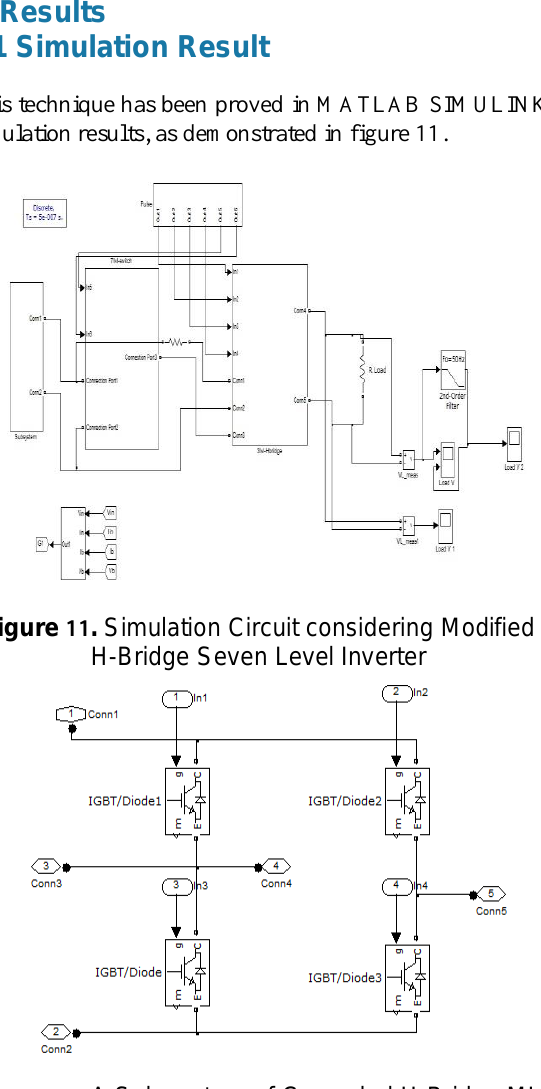
Figure 12 . A Sub-system of Cascaded H-Bridge MLI